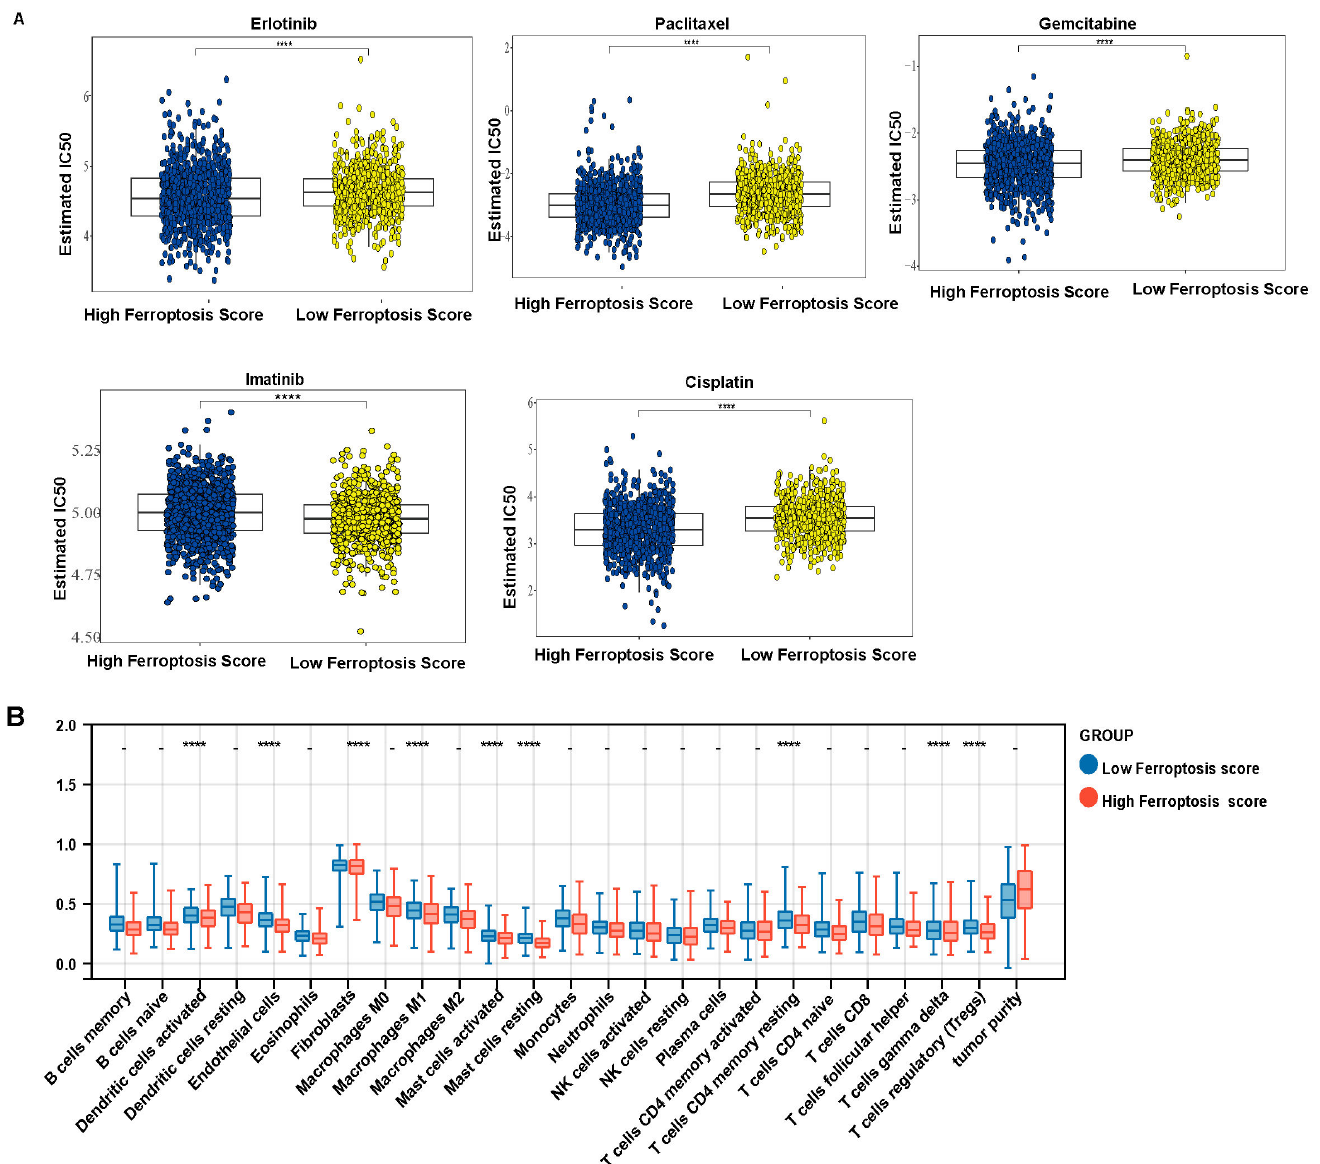
Figure 9. The estimated IC50 values of drugs and immune cell ratios. ( A ) The estimated IC50 values of erlotinib, paclitaxel, gemcitabine and cisplatin in the high and low ferroptosis score groups. ( B ) Immune infiltration distribution for 24 immune cells and tumor purity in two risk groups (group differences were analyzed using binary logistic regression analysis, with tumor purity corrected as the confounding factor. The Bonferroni correction was applied for multiple-comparison correction, **** p < 0.0001; − p >